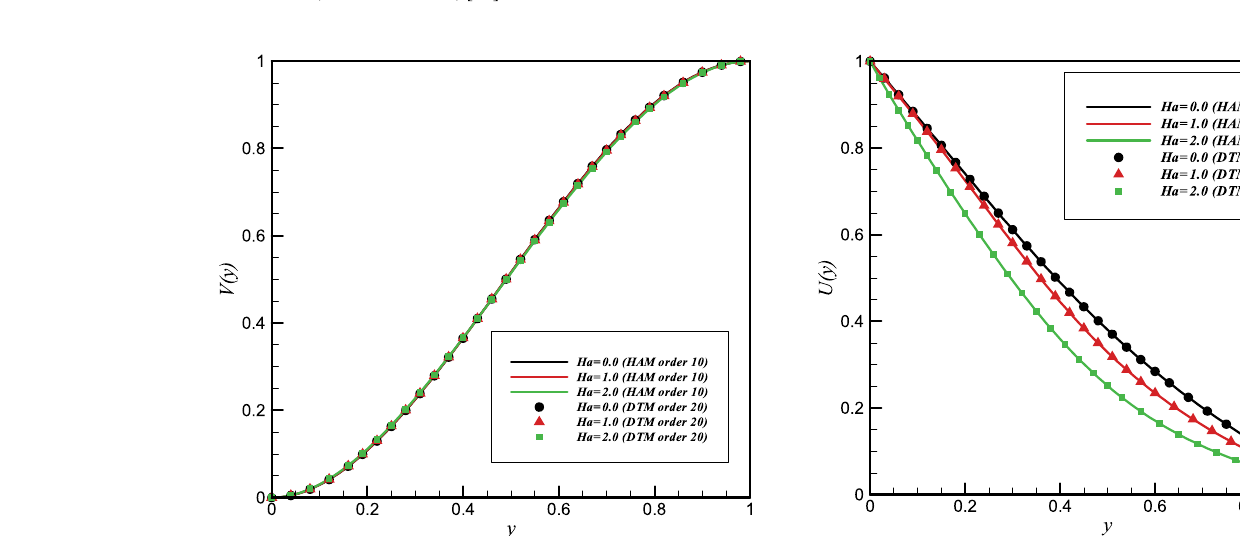
Fig. 13. The profile V (cid:2) ( y ) obtained by the 10th-order approximation of the HAM and 20th-order approximation of the DTM for different values of Ha, when Re = 1 . 0 , [45].